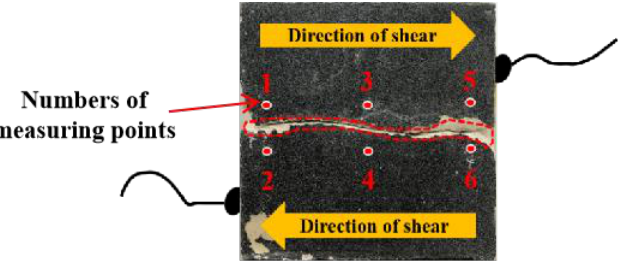
Figure 9. Location map of measuring points.